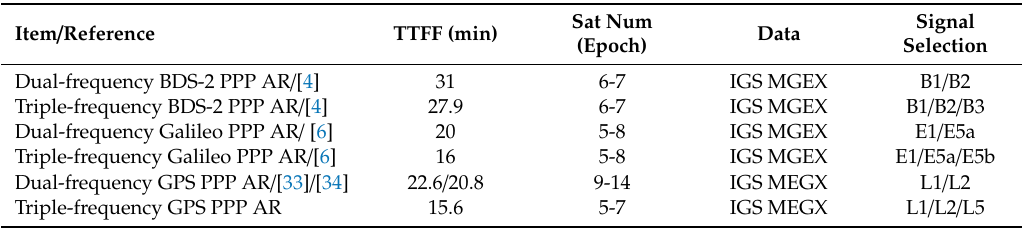
Table 4. Performance comparison of dual-frequency and triple-frequency PPP AR for BDS-2, Galileo and